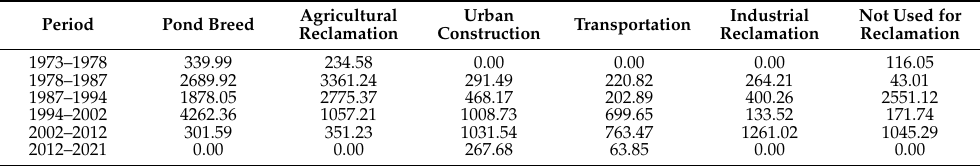
Table 5. Reclamation Structure in Different Periods (unit: ha).